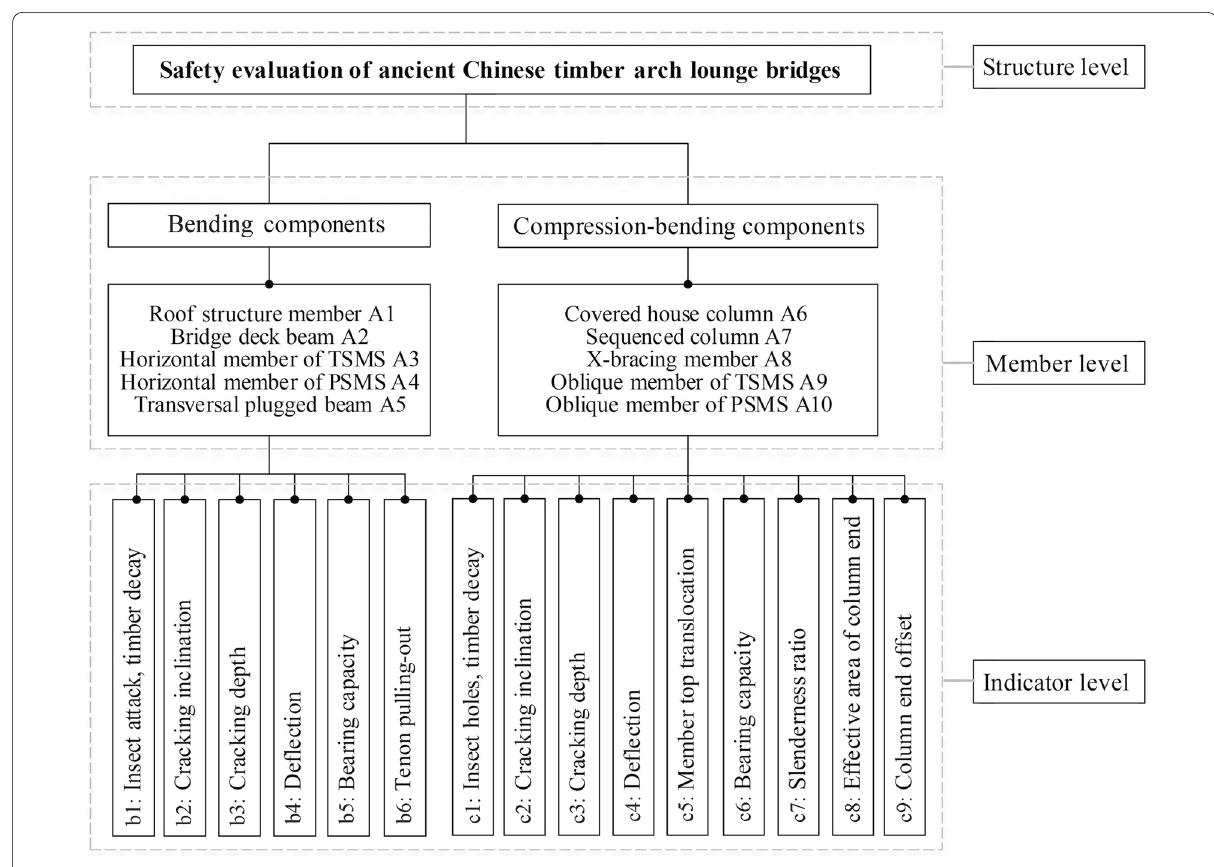
Fig. 4 Structure safety evaluation system of the timber lounge bridge